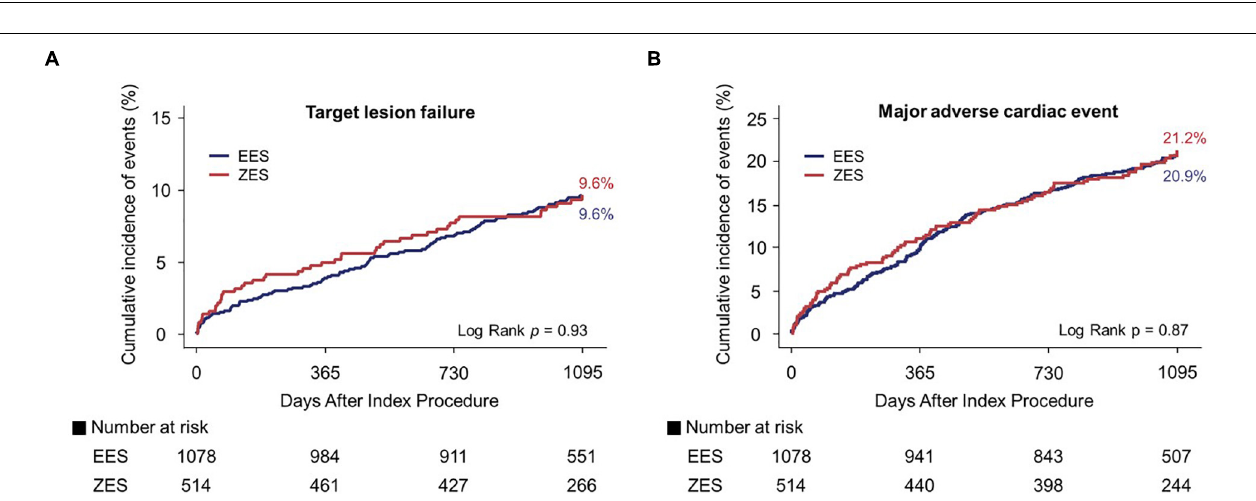
FIGURE 3 | Kaplan–Meier curves for 3-year target lesion failure (TLF) and major adverse cardiac events (MACE). TLF (A) and MACE (B) . EES, everolimus-eluting stent; ZES, zotarolimus-eluting stent.